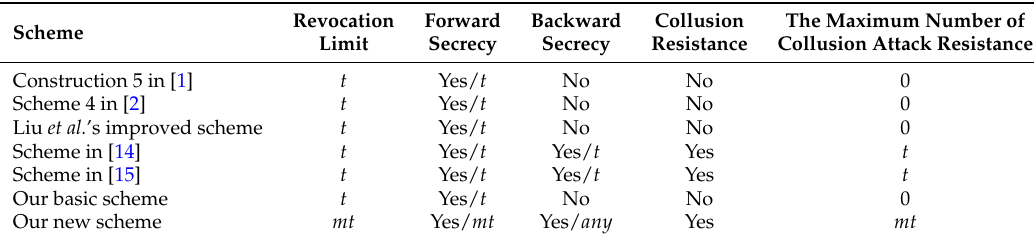
Table 2. Comparison of security properties.